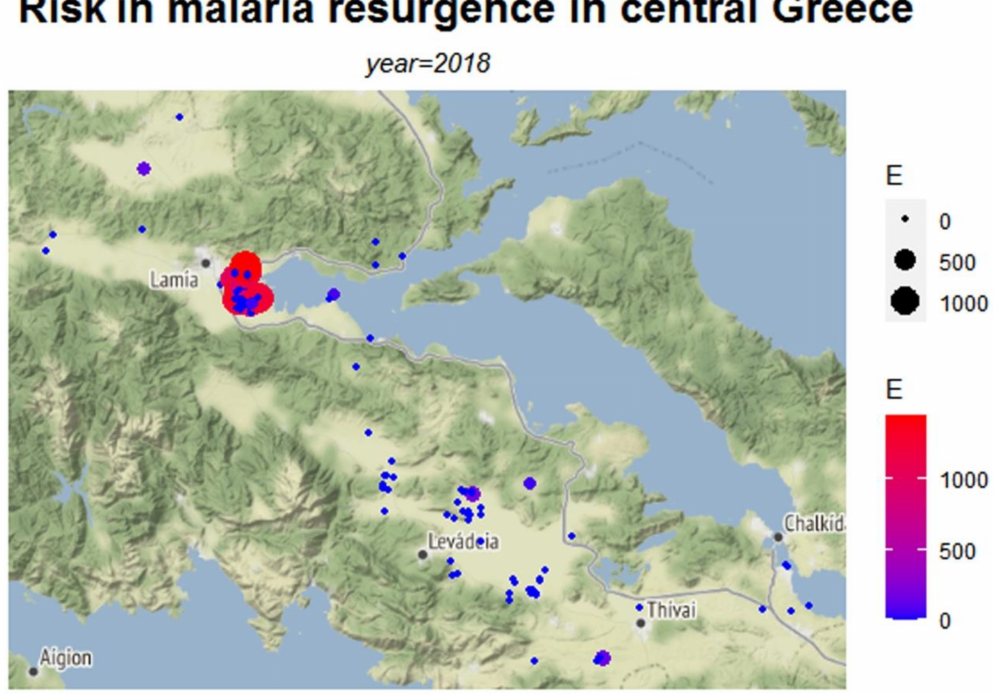
Figure 4. Map of risk of malaria transmission, computed by the EWS model ( E